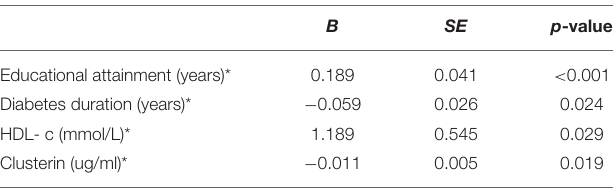
TABLE 7 | Assessment results of the risk of having MCI in a multivariable logistic regression model in patients with T2DM. B SE p